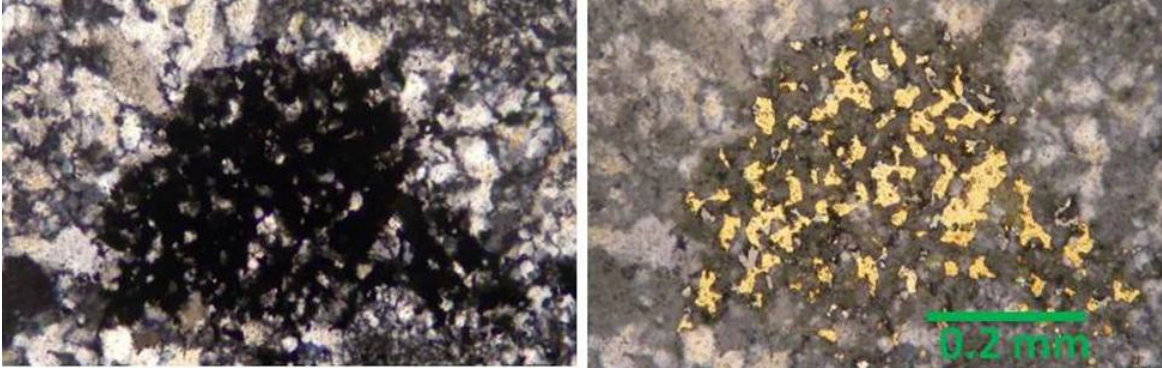
Figure 5. Photomicrographs of a single electrum dendrite from the electrum-rich band shown in Figure 4. Note similarity to Figure 3 from the Sleeper Deposit. Left : Transmitted light, polars crossed, opaques consist of >95% electrum; Right : Same view as at left, transmitted and reflected light. The gray reflective phase is a minor amount of naumannite, also contributing to the structure of the